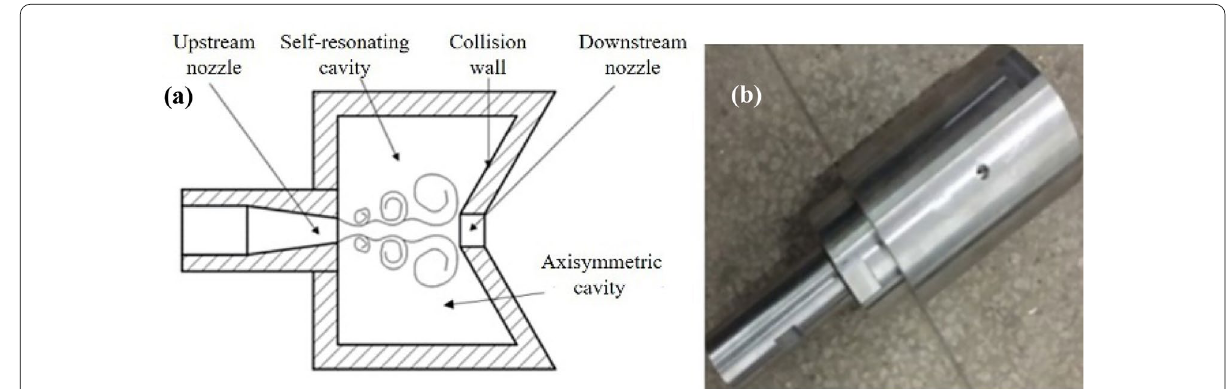
Figure 2 Schematic diagram ( a ) and photograph ( b ) of 120°-impinging edge Helmholtz